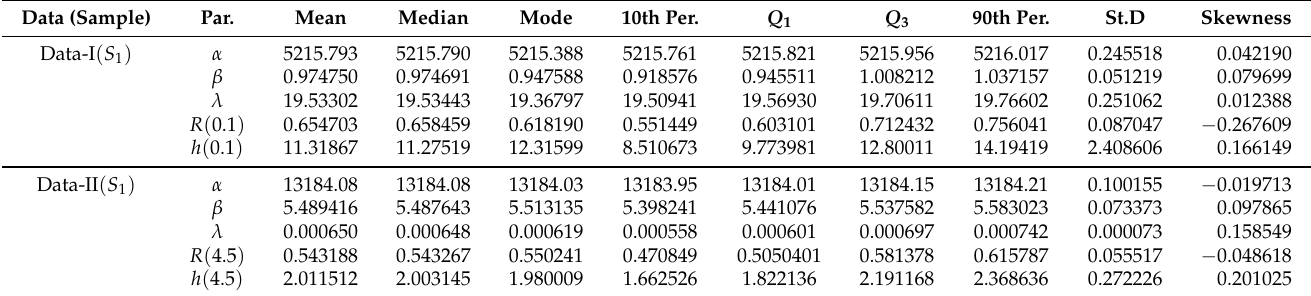
Table 8. Vital characteristics of MCMC outputs under real data